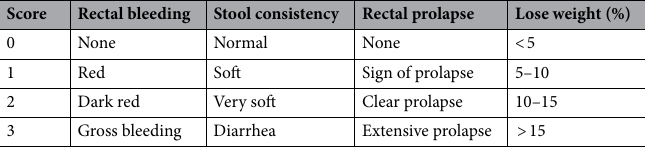
Table 1. The Ulcerative Colitis Disease Activity Index (UCDAI) scoring system.